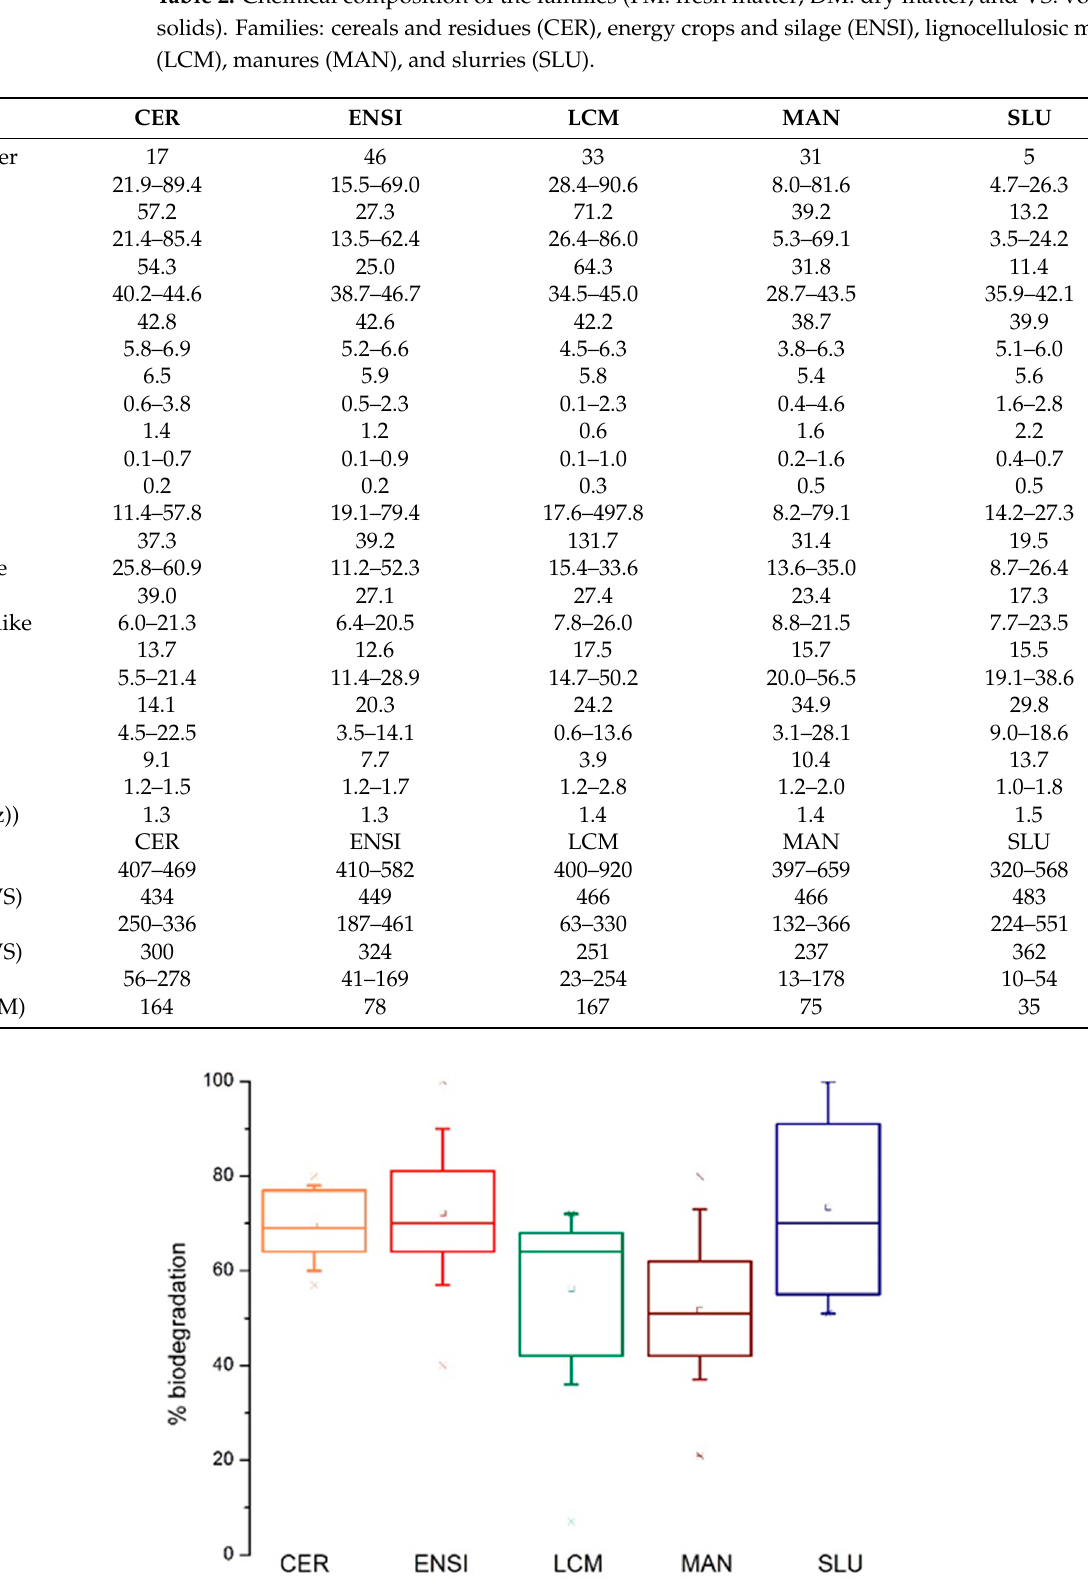
Figure 4. Boxplots of biodegradation yields of the five families. Medians are the horizontal lines and means are represented by squares. Families: cereal and residue (CER), energy crops and silage (ENSI), lignocellulosic matter (LCM), manure (MAN), and slurry (SLU). A majority of families presented a good biodegradation rate, with means between 52 and 73%. Lower degradation rates of only 52 and 56% were reported for manure and lig- nocellulosic matter, respectively. As manure is a mixture of feces and bedding material, depending on the bedding material used and its concentration, it is not surprising to find similar results between these two families [47]. The biodegradability of organic substrates has been well-documented in the literature for various organic substrates [5,14,15,17,24]. Regarding lignocellulosic biomasses, Triolo et al. (2012) reported biodegradability indices of 32.7%, 39.9%, 44.9%, and 66.6% for wood cuttings, hedge cuttings, wild plants, and lawn cuttings, respectively. Similarly, Li et al. (2013) reported biodegradability indices of 51%, 54%, and 62% for corn stover, wheat straw, and rice straw, respectively. Similarly, Li et al. (2013) reported biodegradation rates of 10%, 63%, and 68% for dairy manure, chicken